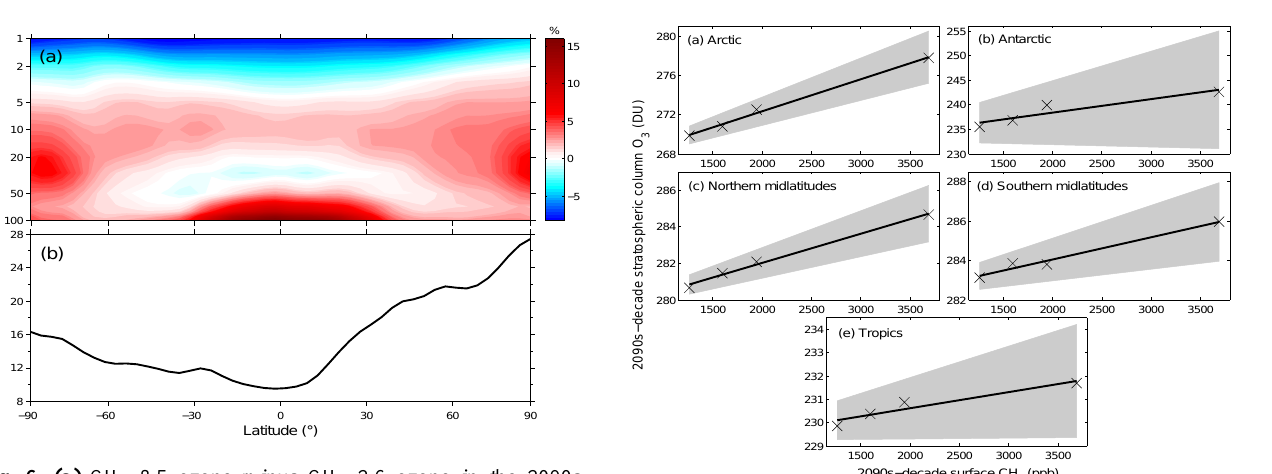
Fig. 6. (a) CH 4 -8.5 ozone minus CH 4 -2.6 ozone in the 2090s decade, calculated as a percentage of ozone in the CH 4 -2.6 simula- tion. (b) 2090s-decade CH 4 -8.5 total column ozone minus CH 4 -2.6 total column ozone.